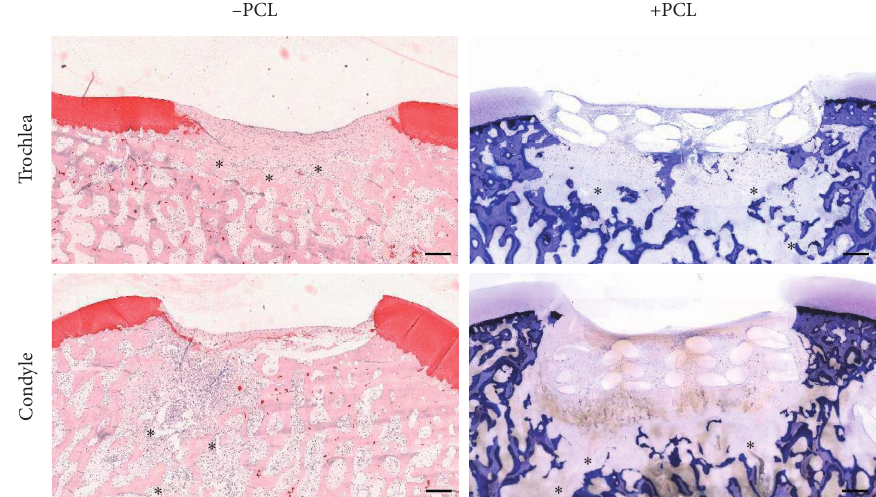
Figure 4: Histological evaluation of the defects 4 weeks after implantation into trochlea and condylar defects. Collagen type II staining of nonreinforced constructs. Toluidine blue staining of PMMA embedded PCL containing defects. In all osteochondral defects, regardless of PCL-reinforcement, osteolysis of the subchondral bone was found. ∗ : bone lysis. Scale bar: 500 μ m. –PCL